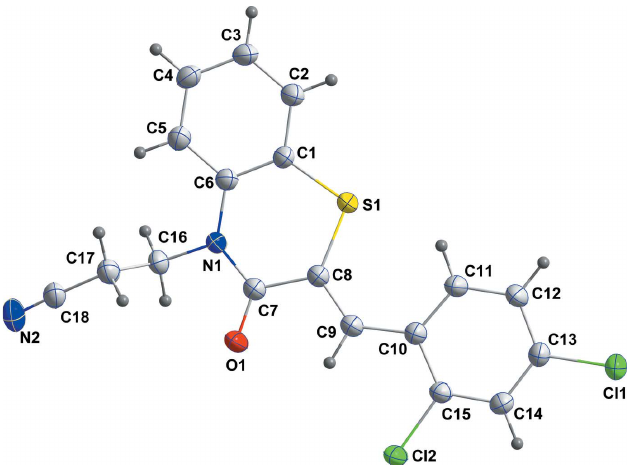
Figure 1 The molecular structure of the title compound with the atom-numbering scheme. Displacement ellipsoids are drawn at the 50% probability level.